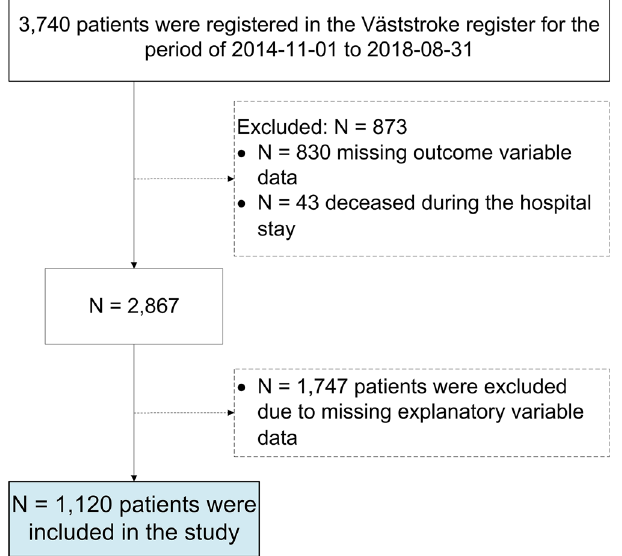
Figure 1. Flowchart of the study